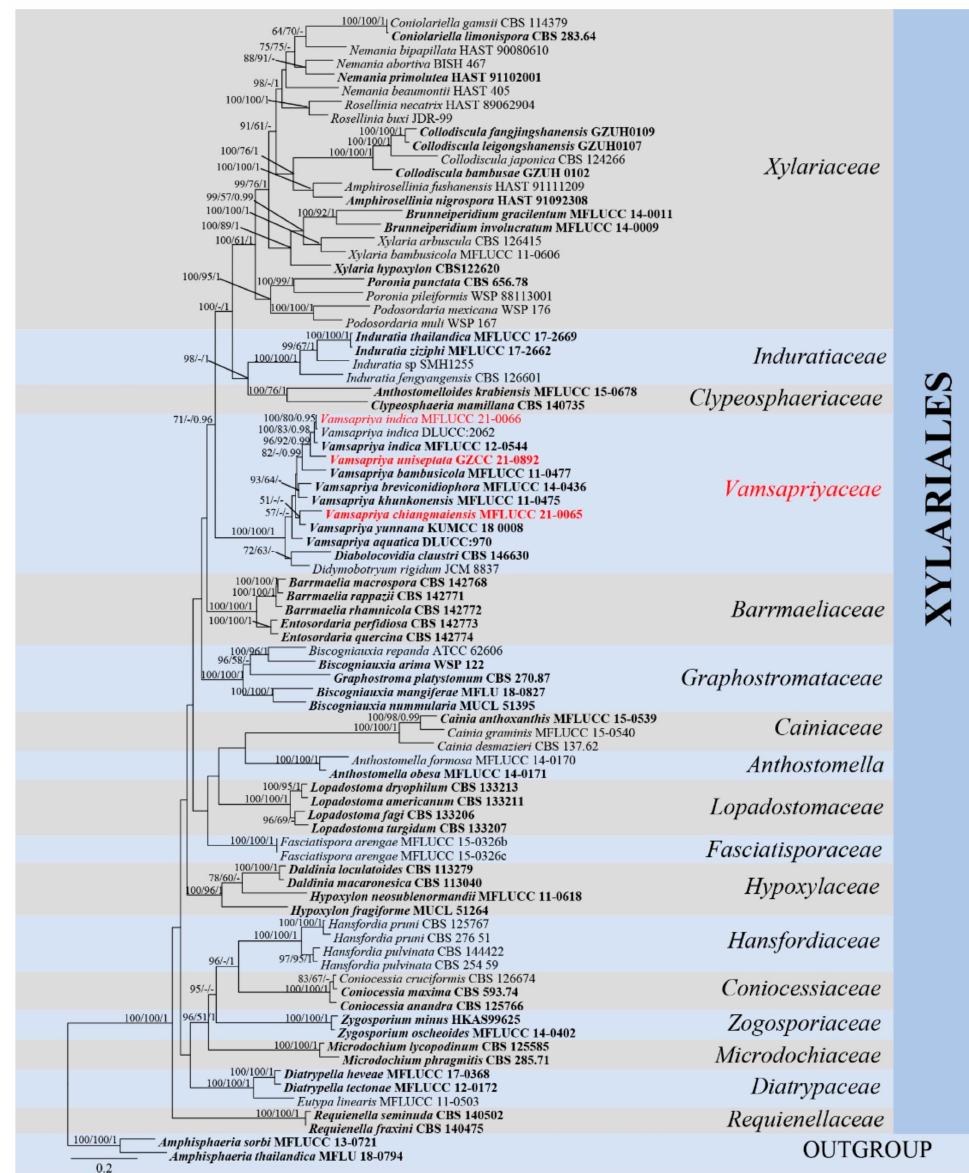
Figure 1. Maximum likelihood (RAxML) tree, based on analysis of a combined dataset of LSU , rpb2, tub2 and ITS sequence data. The tree is rooted with Amphisphaeria sorbi (MFLUCC 13-0721) and A. thailandica (MFLU 18-0794). Bootstrap support values for ML and MP greater than 50% and Bayesian posterior probabilities greater than 0.95 are given near nodes, respectively. Ex-type strains are in bold, the new isolates are in